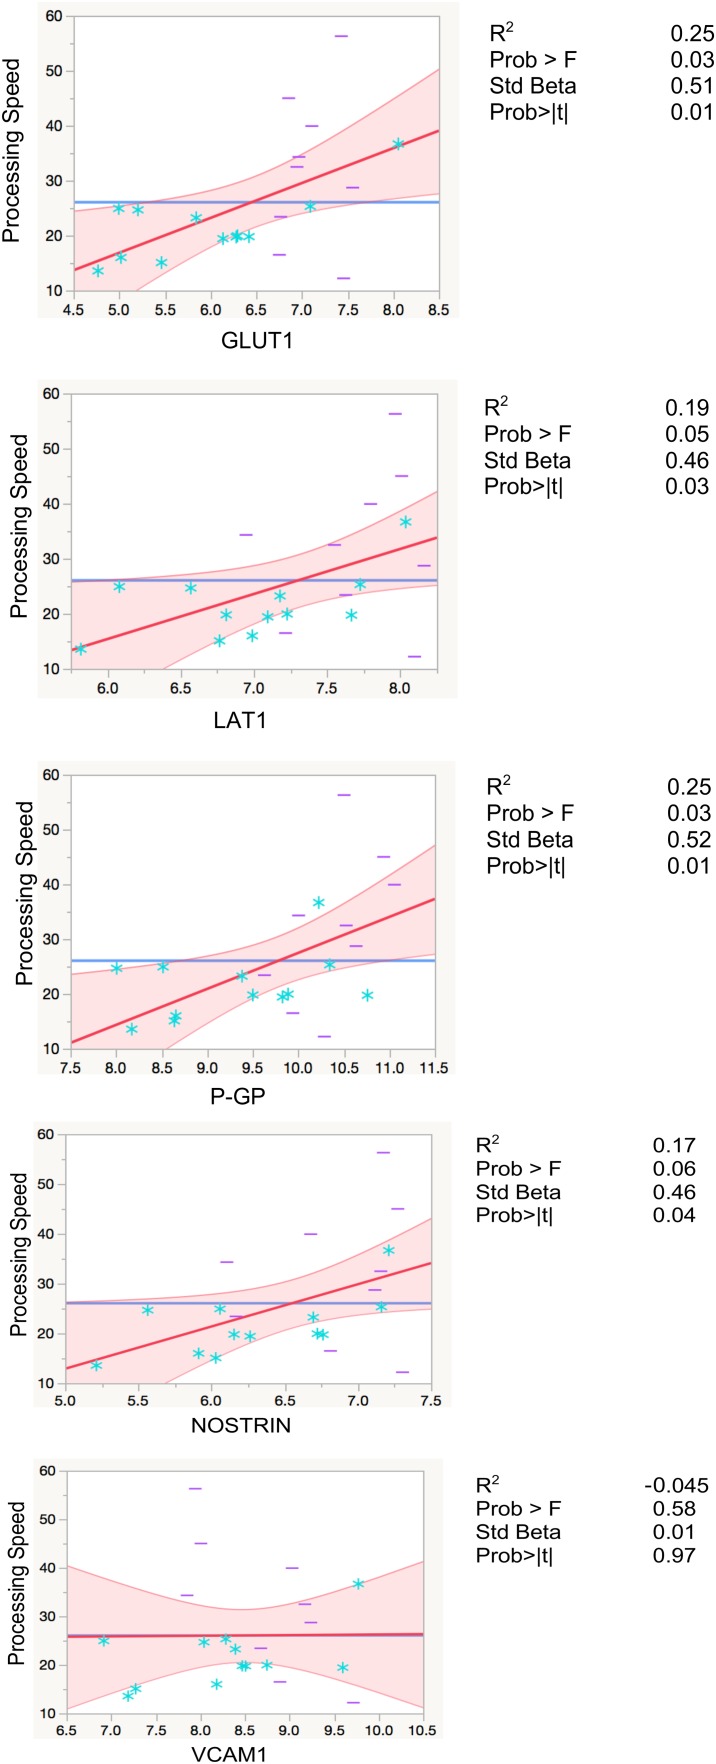
Regression models with processing speed. Leverage residuals plots of normalized levels of EDE cargo biomarkers associated with cognition (processing speed) where units are in seconds. Distributions were normalized via log transformation. All regressions were adjusted for age. R2 values are adjusted for number of predictors in regression model. All values are rounded to two significant digits. Blue stars: controls; purple dashes: cases.